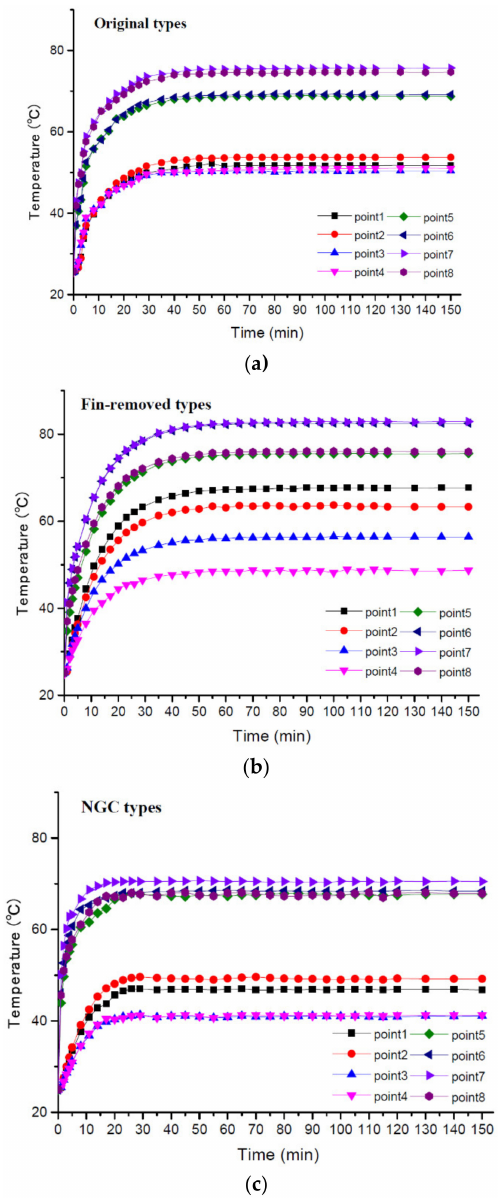
Figure 11. Variation of temperature for the di ff erent LED lamps. ( a ) Variation of temperature for points 1–8 of the original lamp. ( b ) Variation of temperature of points 1–8 for the fin-removed lamp. ( c ) Variation of temperature for points 1–8 of the NGC